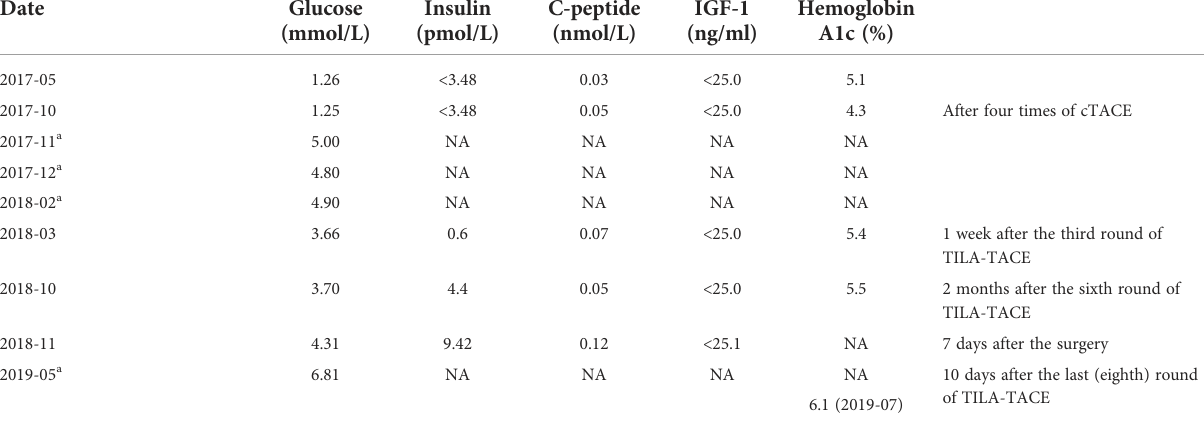
TABLE 1 The patient ’ s insulin, C-peptide, IGF-1, and hemoglobin A1c throughout the whole